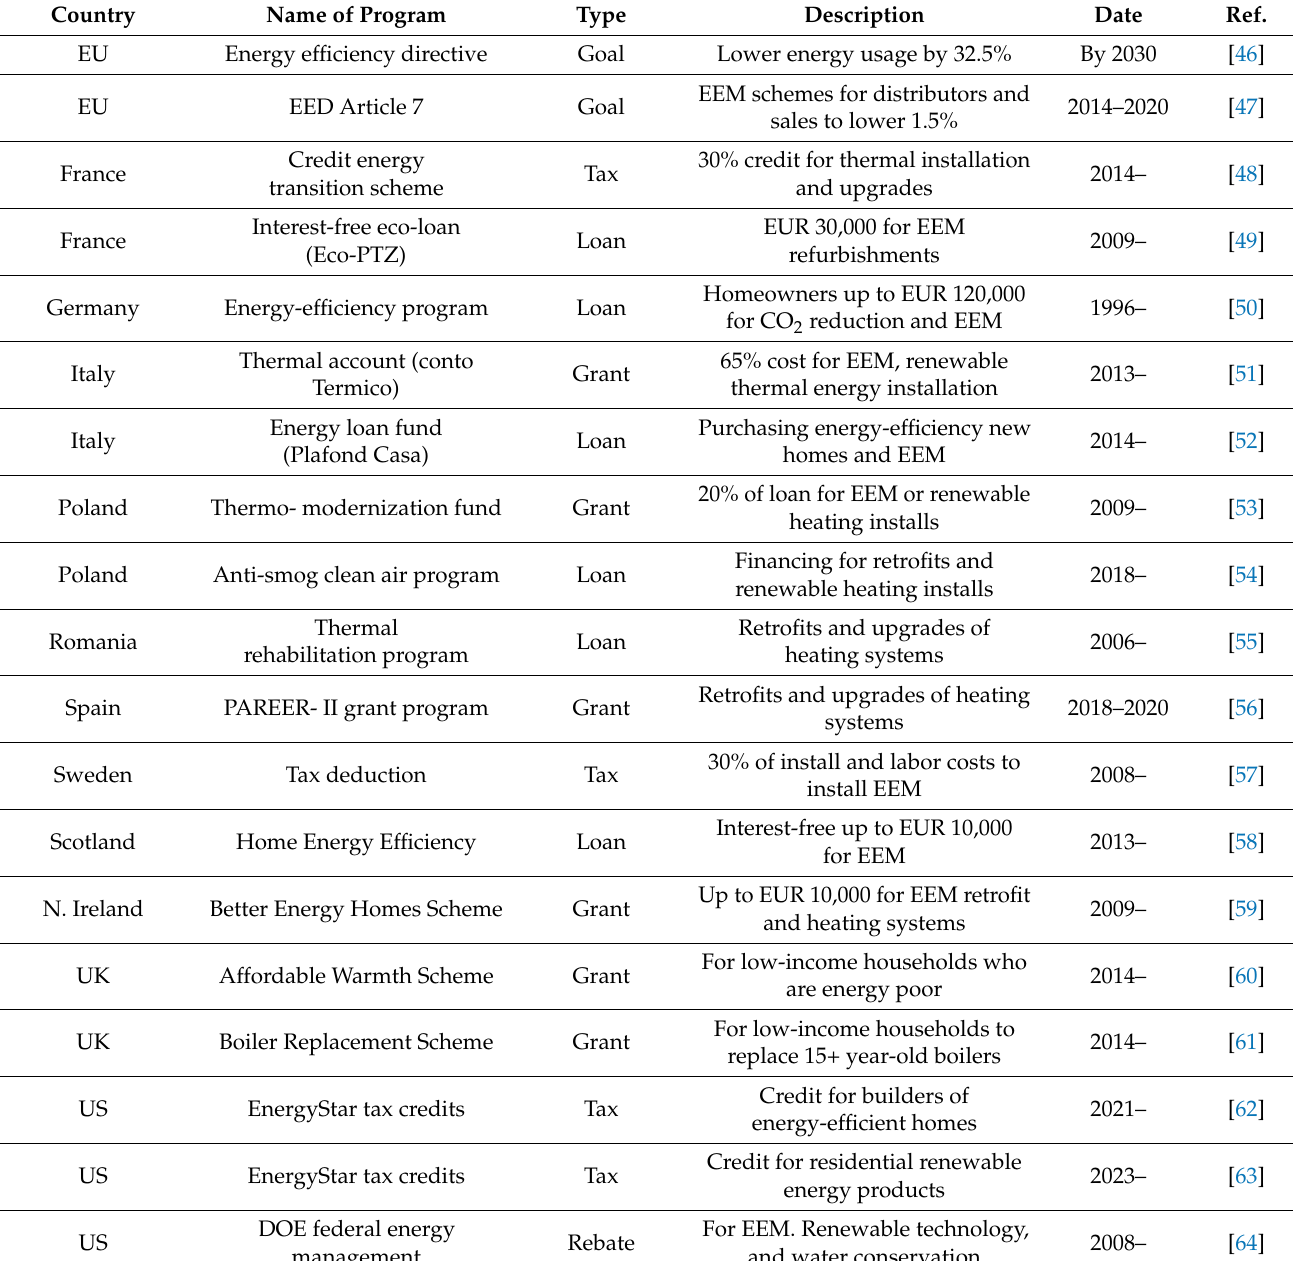
Table 2. Policies and incentive programs in US and Europe